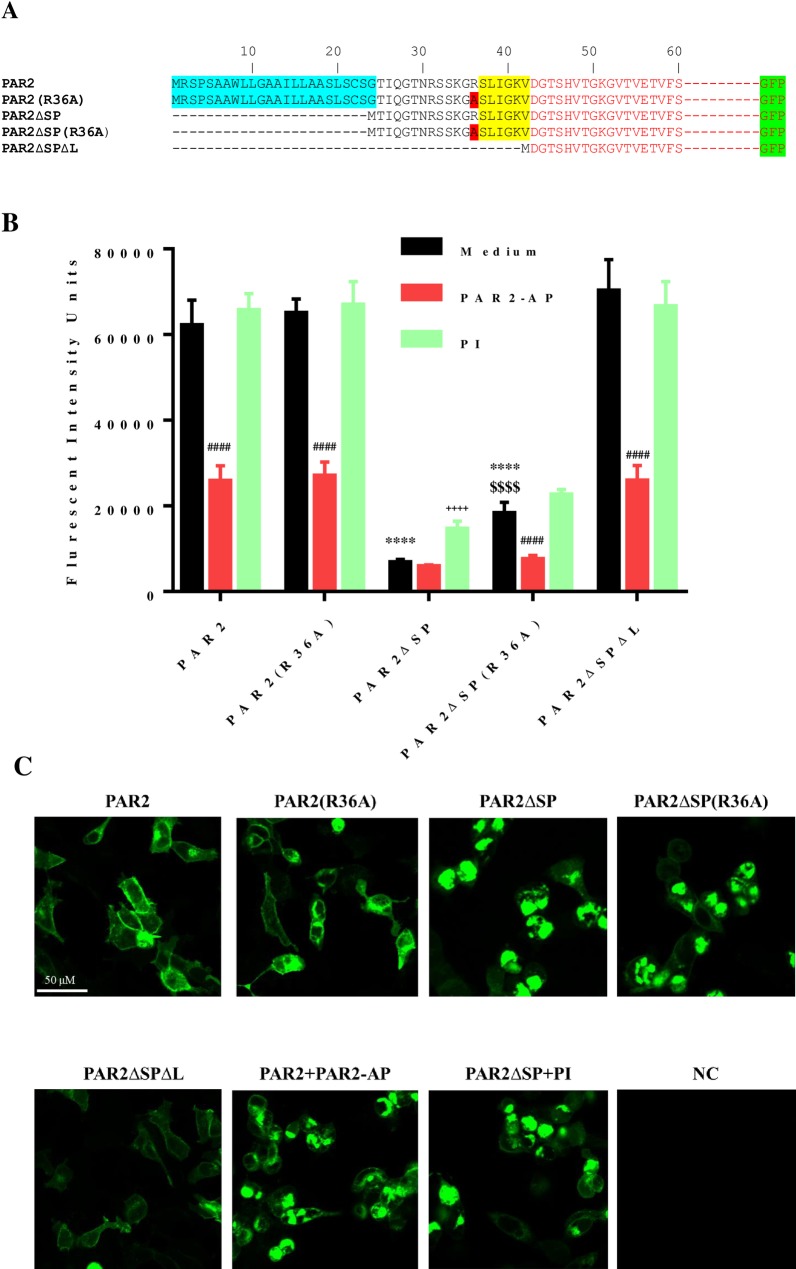
Arg36Ala mutation and protease inhibitors increase the cell surface expression of PAR2-GFP without a signal peptide.A. Schematic presentation of various PAR2-GFP fusion protein expression constructs. B. The expression levels of various PAR2-GFP proteins with treatments of PAR2-AP, or protease inhibitors. Various PAR2-GFP expression constructs were transiently expressed in HEK293 cells with par1 & par2 knocked-out. The transfected cells were treated either with medium (Medium), peptide agonist (PAR2-AP), or a protease inhibitor cocktails (PI), and the fluorescent intensities of the cells expressing the PAR2-GFP fusion proteins were measured. Assays were performed in quadruplicates at each data point and the results shown are mean ± sd. Statistical analysis (One-Way ANOVA) showed that compared with PAR2, PAR2ΔSP and PAR2ΔSP(R36A) have lower protein expressions (**** p < 0.0001). Compared with PAR2ΔSP, PAR2ΔSP(R36A) has much higher protein expression ($ $ $ $ p < 0.0001). Except for PAR2ΔSP, PAR2-AP decreased protein expressions for all others (#### p < 0.0001). Protease inhibitor cocktails (PI) only increased the protein expression for PAR2ΔSP (++++ p < 0.0001) and did not affect the protein expressions for others. C. Fluorescent images from confocal microscope showing the cellular distributions of various PAR2-GFP fusion proteins under the treatments of PAR2-AP or protease inhibitors. Untransfected cells were used as the negative control (NC). The fluorescent intensities shown in the images are automatically adjusted for better viewing of the protein cellular distributions. The experiments have been performed 3 times and very similar results have been observed. Example data is shown.